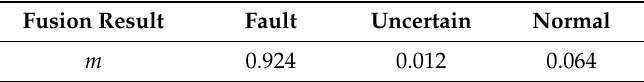
Table 10. The fusion result.